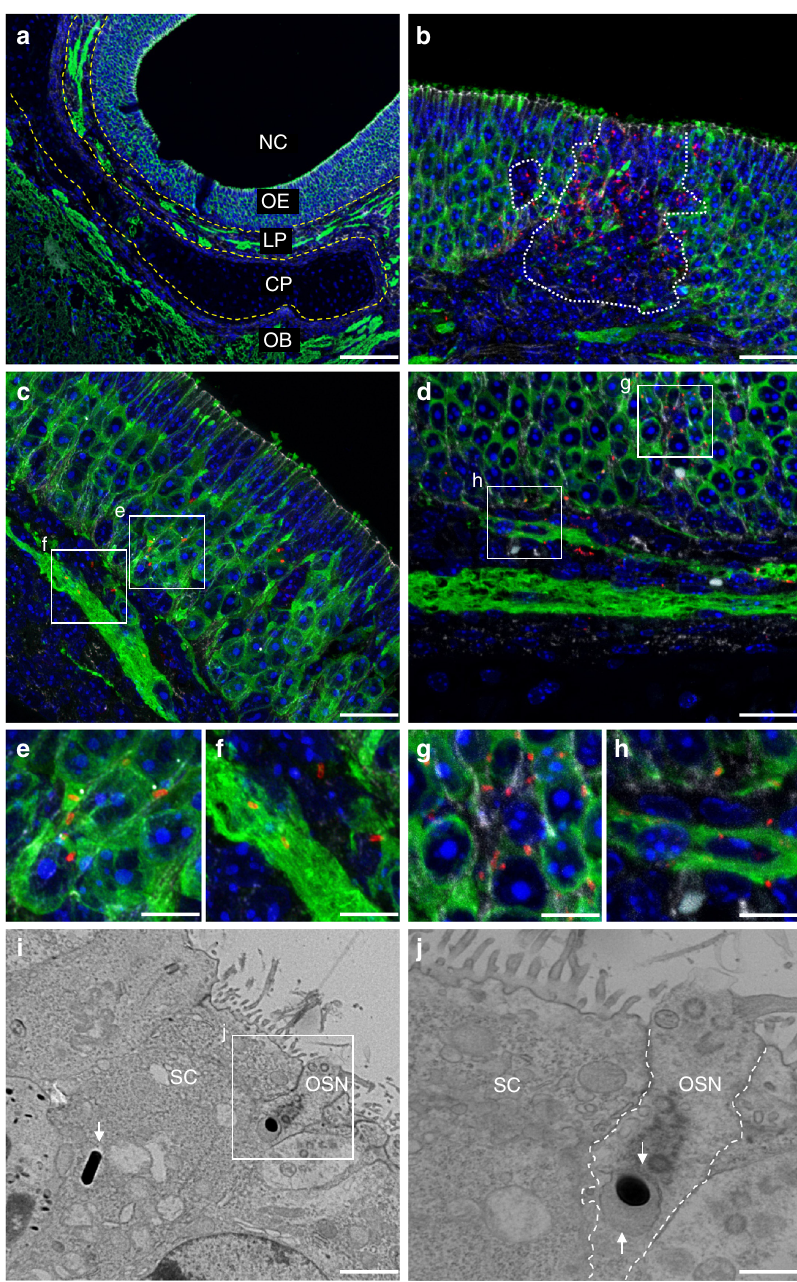
Fig. 3 Lm invades the olfactory mucosa. a – h Immunohistochemistry (IHC) and i and j transmission electron microscopy (TEM) of the olfactory mucosa of 1-day-old mice infected with 1 × 10 7 CFU Lm i.n. or age-matched control animals. For IHC, sections were stained for Lm (red), the neuronal marker β -tubulin III (green), the tight-junction marker β -catenin (white), and DNA (DAPI, blue). a Sagittal view of the olfactory system of a 2-day-old control mouse. Nasal cavity (NC), olfactory epithelium (OE), lamina propria (LP), olfactory bulb (OB), and cribriform plate (CP). b – h IHC of the OE and subepithelial mucosal tissue after i.n. at 1 dpi. Zoomed views of intraepithelia e and g as well as f and h nerve-associated bacteria in the LP. Disruption of the OE is marked with dotted lines b ( a : scale bar 100 µ m, b – d : scale bar 20 µ m, e – h : scale bar 5 µ m). i and j TEM of the OE at 12 hpi, showing Lm within a sustentacular cell (SC; white arrow) and an olfactory sensory neuron (OSN; framed insert, white arrow). Lm is surrounded by a vacuolar structure within the OSN (white arrows in j ) ( i : scale bar 2 µ m, j : scale bar 1 µ m). IHC and TEM images are representative for samples from each n = 8 pups; images of age-matched controls are derived from n = 8